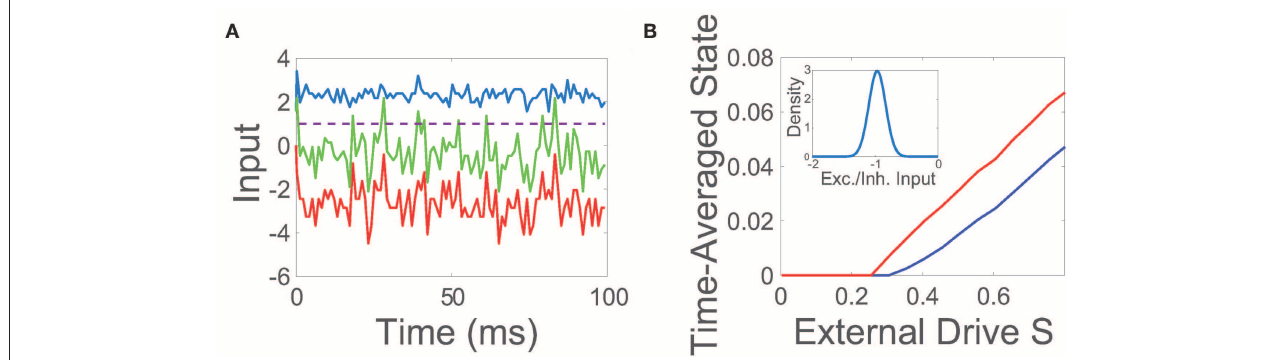
FIGURE 1 | Balanced network dynamics. (A) Excitatory (blue), inhibitory (red), and net (green) inputs into a sample excitatory neuron in a balanced network. The dashed line indicates the firing threshold. (B) The time-averaged state of the excitatory (blue) and inhibitory (red) population as a function of external input scaling strength S . Inset: Probability density of the time-averaged ratio of excitatory and inhibitory inputs across the network. Unless otherwise specified, parameters utilized R IE are R EE 1, R II 1.8, R EI 2, N E 800, N I 200, f E 1.2, f I 1, K 0.03 N E , θ E 1, and θ I 0.7. The external drive into a neuron in the k th population = = = − = − = = = = = = = is an excitatory constant current that is independently generated and identically uniformly-distributed with O ( √ K ) magnitude scaled by f k